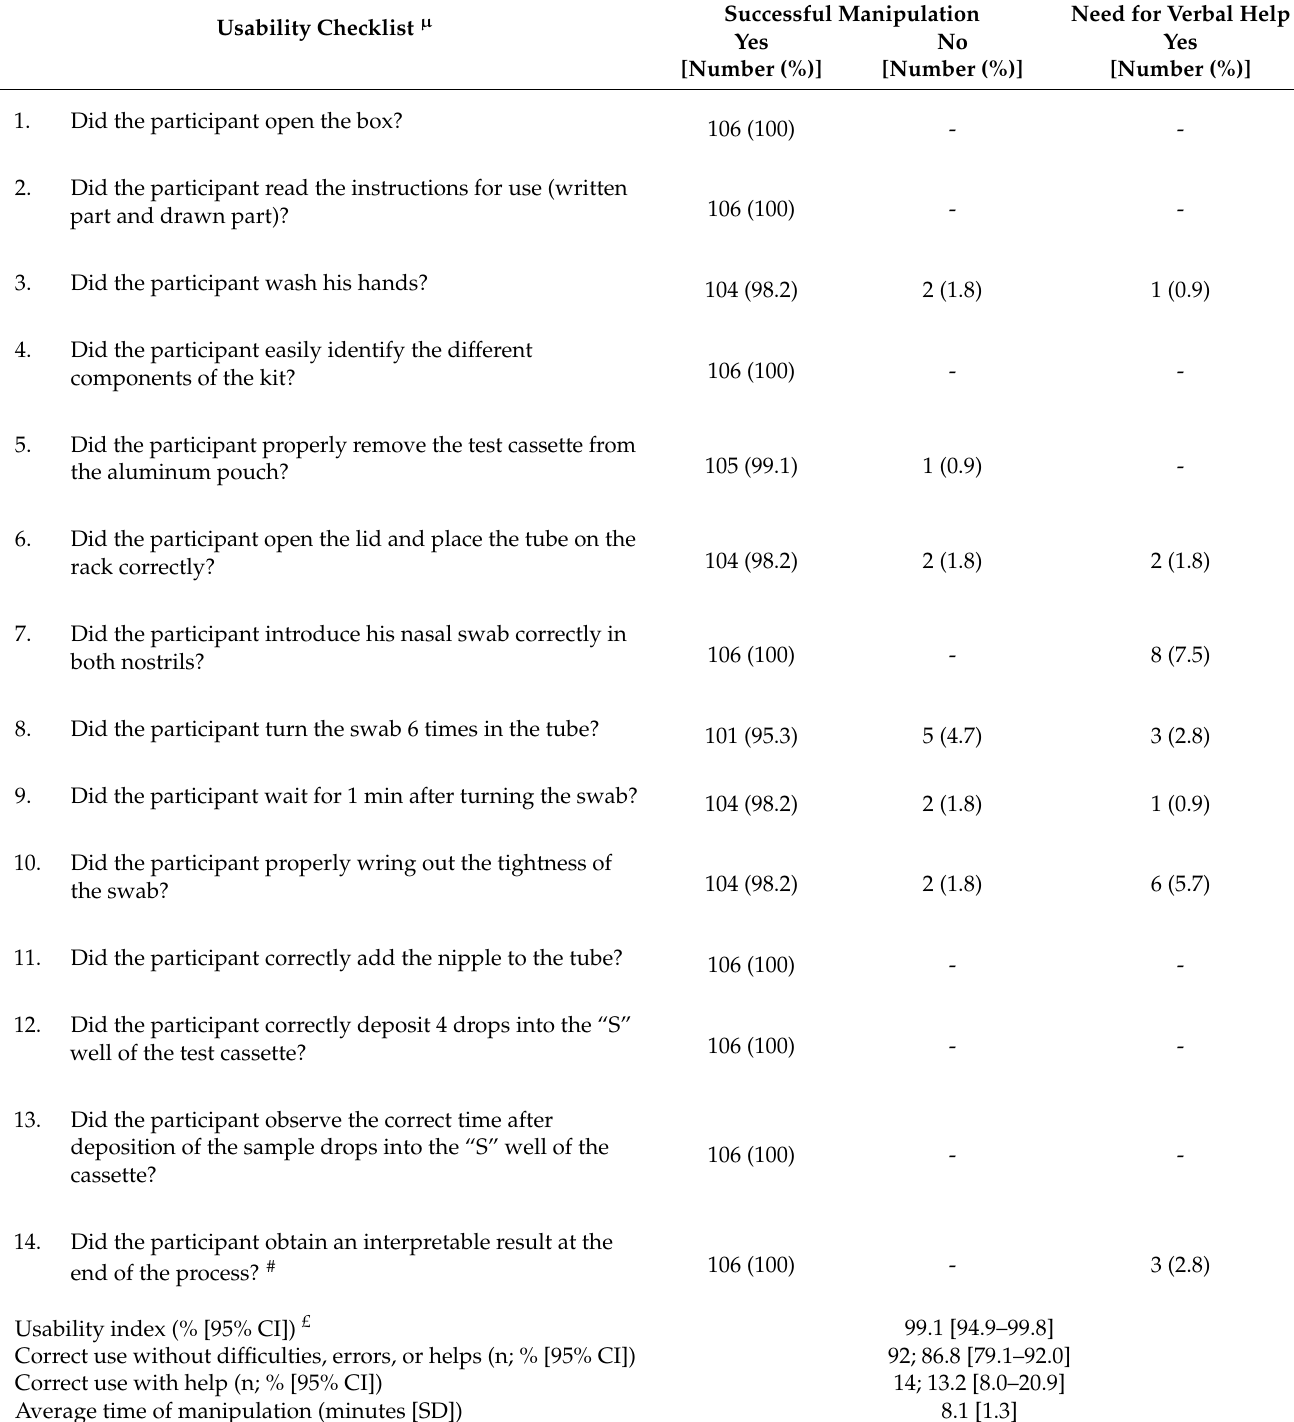
Table 3. Analytical results of the manipulation observation concerning the ability of Table, 106 study participants to correctly use each step of the BIOSYNEX Antigen Self-Test COVID-19 Ag+ (Biosynex Swiss SA) autonomously or with verbal help. Usability Checklist